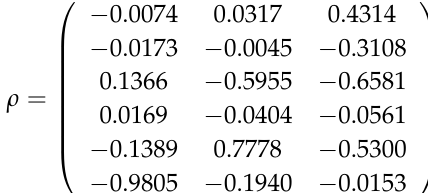
Figure 4. Log-likelihood costs of the p-dimensional subspaces of the first two HB1 data sets. The upper dashed line represents the chi-square quantile χ 2 at 0.1%. 628 x